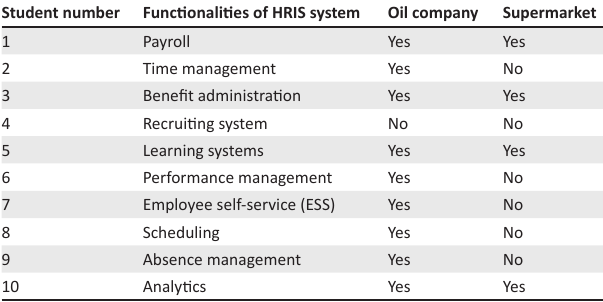
TABLE 1: Summary of the functionalities in the human resource information systems of both retailers. Student number Functionalities of HRIS